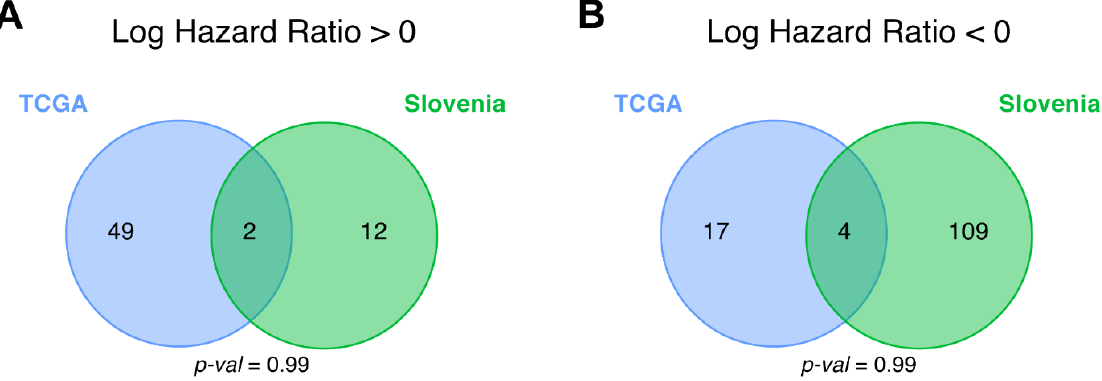
Figure 8. Intersections of differential ( A ) plus (hazard ratio > 0) and ( B ) minus (hazard ratio < 0) molecular pathways for progression-free survival (PFS) analysis between CGGA_325, CGGA_693, TCGA and the experimental (Slovenia) glioblastoma samples.